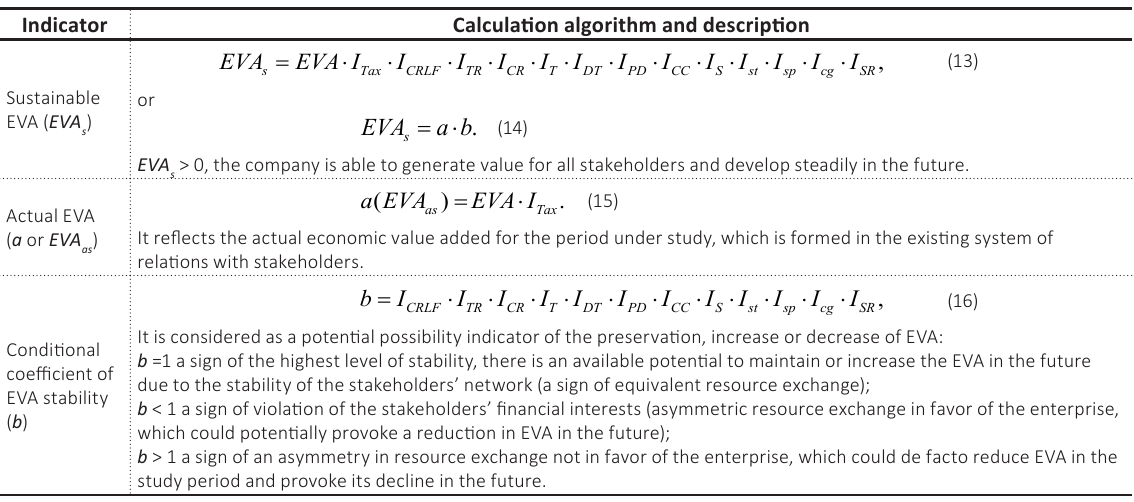
Table 3. Model of integrated assessment of EVA storage potential